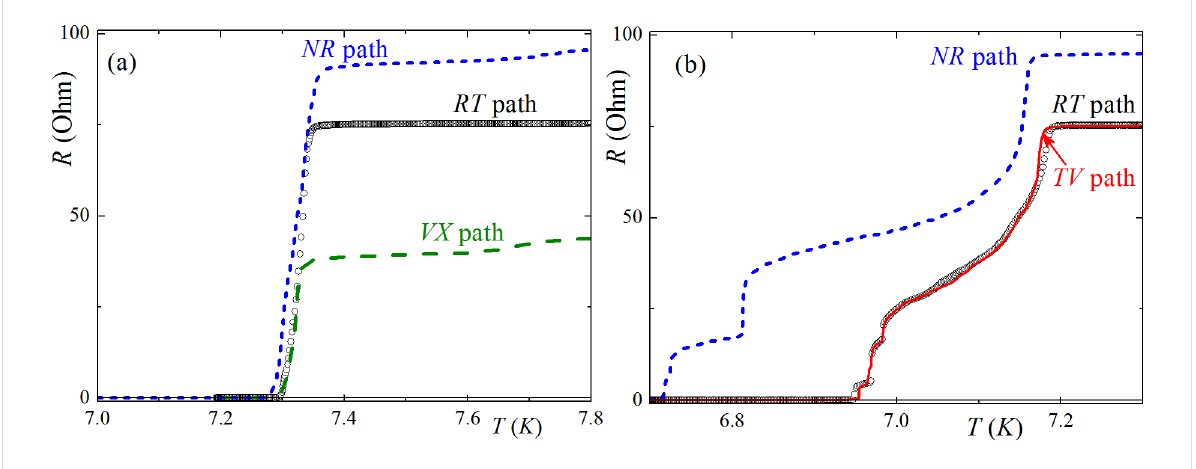
Figure 5: Resistance as a function of the temperature (a) without an initial magnetization of the sample, at a current I = 20 μ A, and (b) after remagne- tization in the longitudinal direction, at a current I = 1 mkA. Each contact in the “centipede-like” structure was marked with a letter. Therefore, each measurement was denoted by a pair of letters ("RT", "TV",